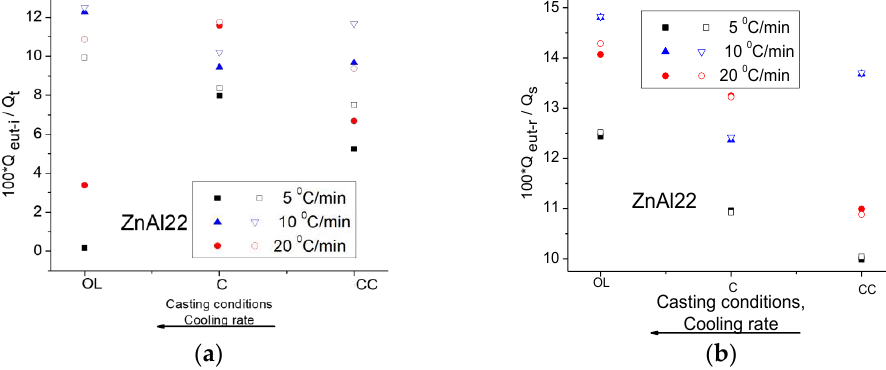
Figure 9. Ratio of the eutectic heat transformation of the total heat required for the state of aggregation: ( a ) during heating and ( b ) during cooling.